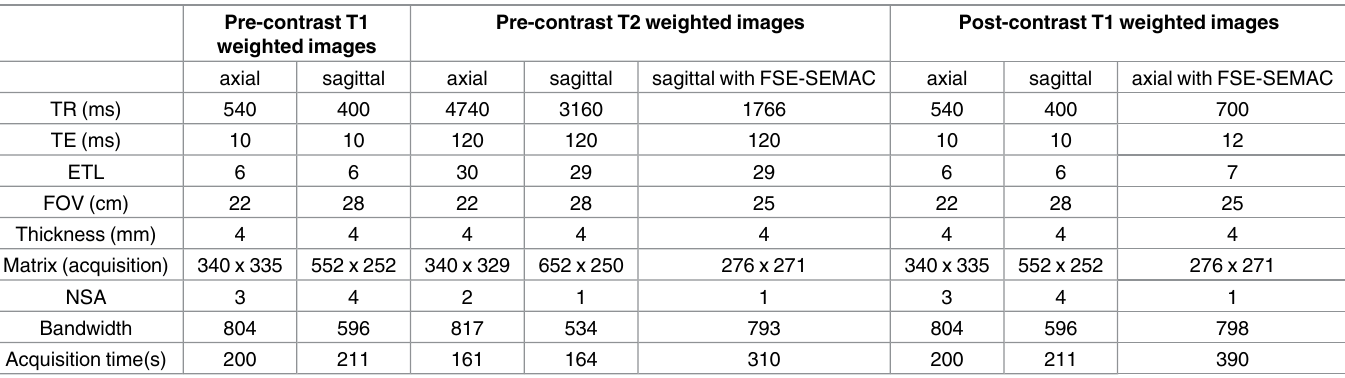
Table 1. MRI parameters.